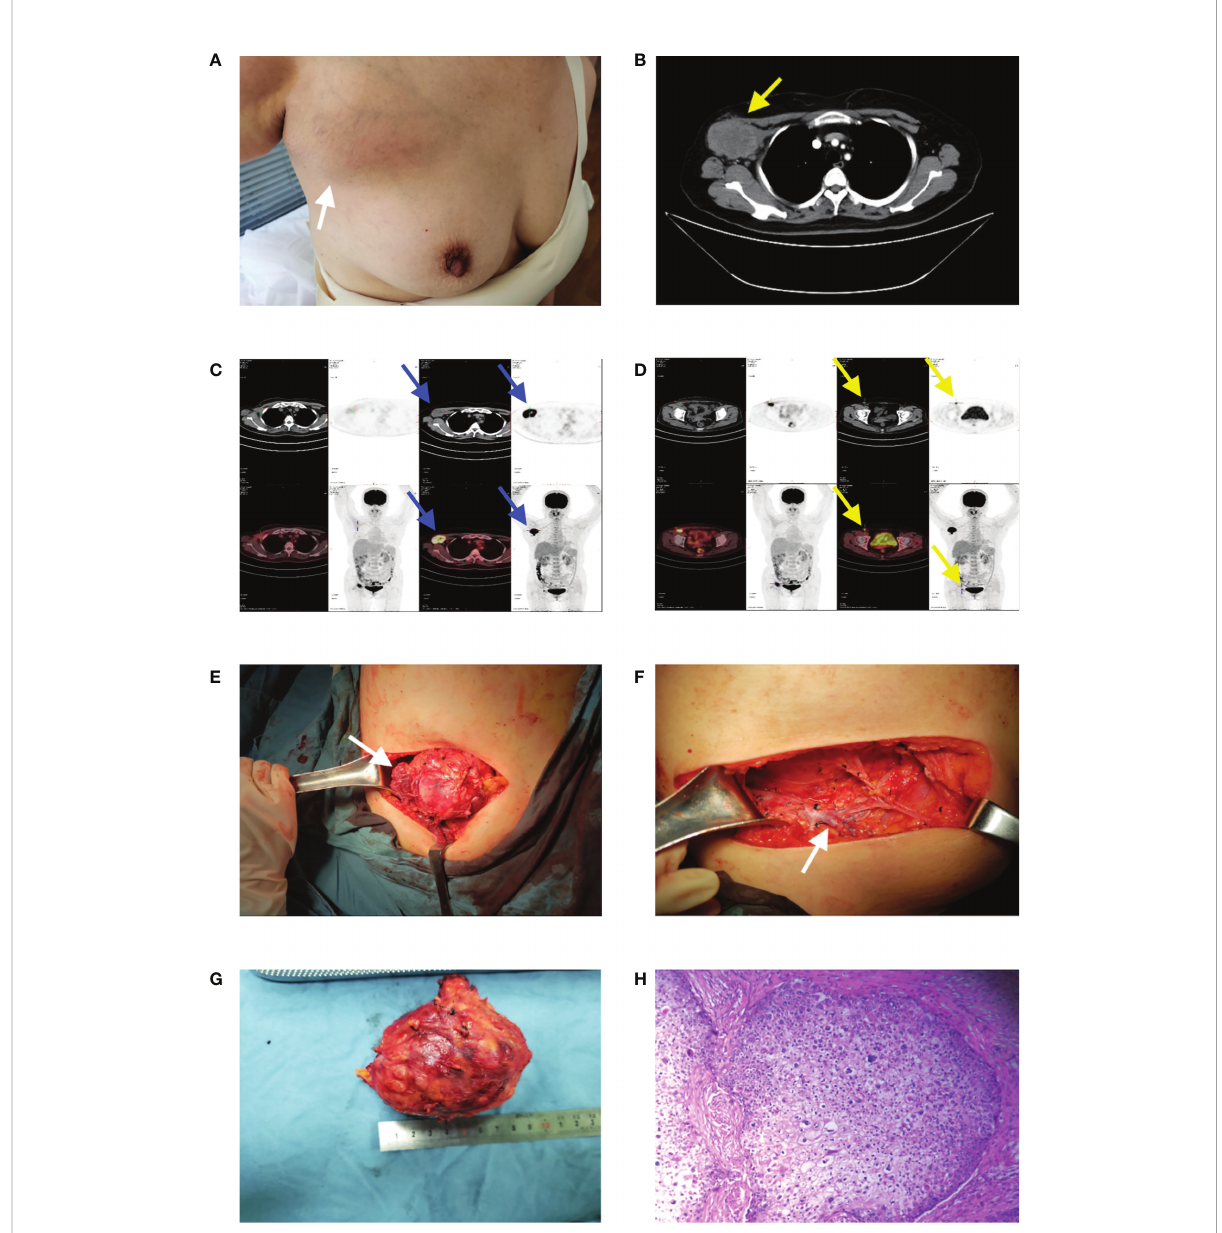
FIGURE 2 (A) A mass in the right axilla. (B) Preoperative enhanced CT revealed a soft tissue density mass (yellow arrow) in the right axilla with a size of 6.9 × 5.2 cm. (C, D) PET-CT showed the mass as axillary lymph node metastasis (blue arrows) and another metastasis located at the ipsilateral inguinal lymph node (yellow arrows) which were characterized by shapes of nuclide accumulations in PET-CT image. (E) An intraoperative view from above, showing the tumoral invasion of the pectoralis major and minor muscles (white arrow). (F) An intraoperative view from above, showing the axillary vein (white arrow) after ALND. (G) The tumor was 7 cm in diameter. (H) The HE ×100 showed the tumor was characterized by a proliferation of tumoral lobules composed of large, atypical cells with clear